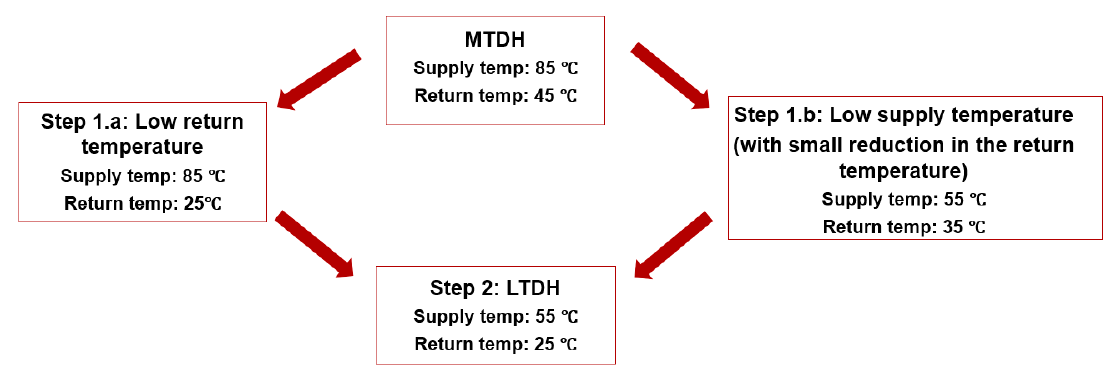
Figure 1. The transition from medium-temperature district heating (MTDH) to low-temperature district heating (LTDH).